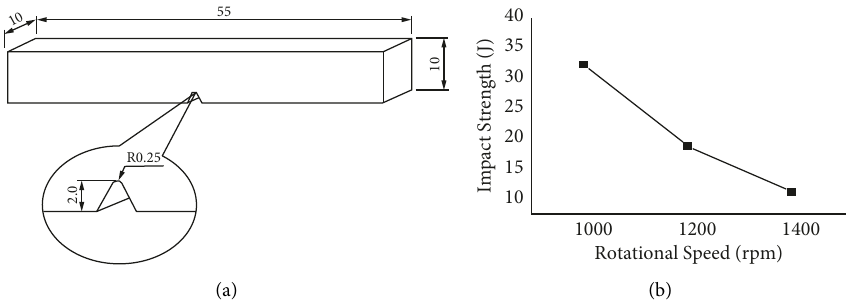
Figure 10: (a) The dimensions of Impact test specimen, (b) impact strength of Cu-Br welded joint at various